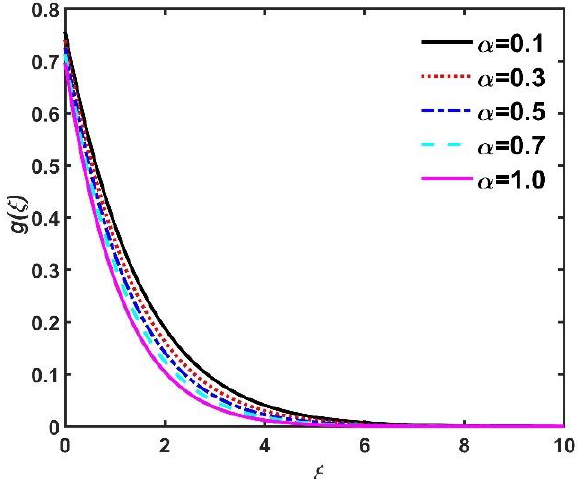
Figure 3. Impact of 𝛼 on 𝑔(𝜉) .